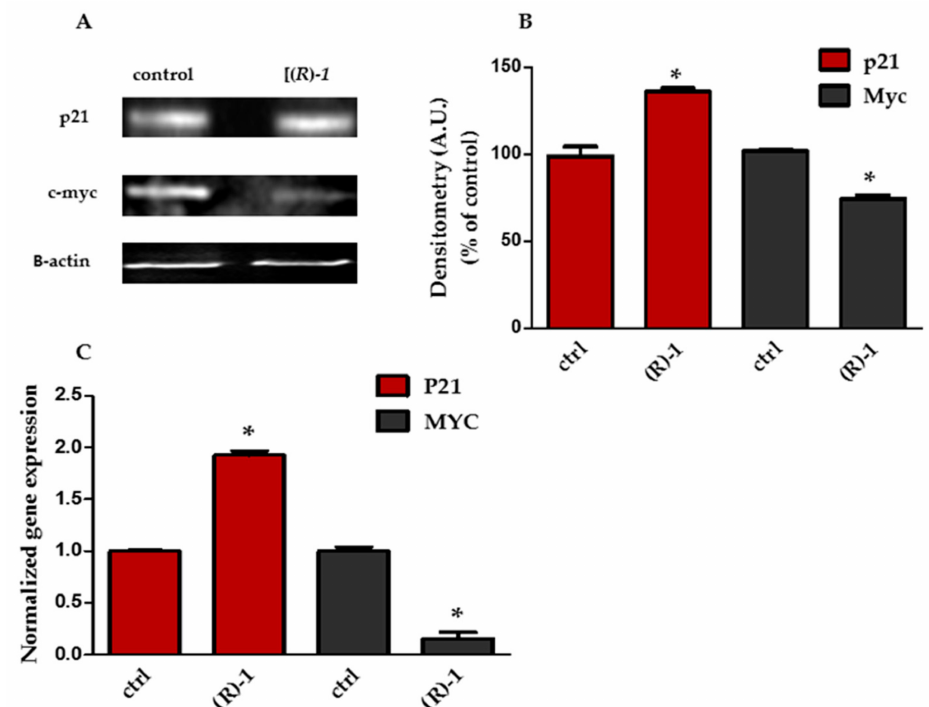
Figure 7. The e ff ects of ( R ) - 1 on the expression of cell growth regulatory genes and proteins in HT29 colon cancer cell line. A ) Representative western blots for p21 and MYC in HT29 cells following 6 h treatment with ( R ) - 1 . β -actin was used as the control. B ) Densitometry from western blots